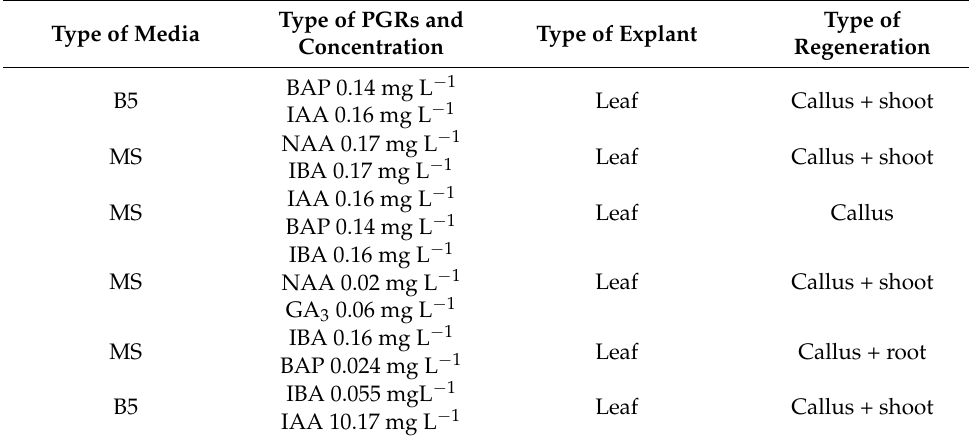
Table 1. In vitro callus production from Cichorium intybus L. Type of